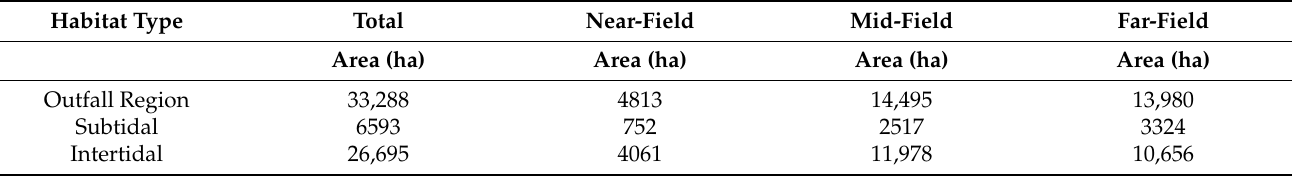
Table 2. The distribution of subtidal and intertidal areas in the near-field, mid-field and far-field outfall region impacted by water from river input discharged from the Caernarvon diversion when operating (degree of exchange based upon estimates of 6 and 10 km radius from diversion structure from evidence in